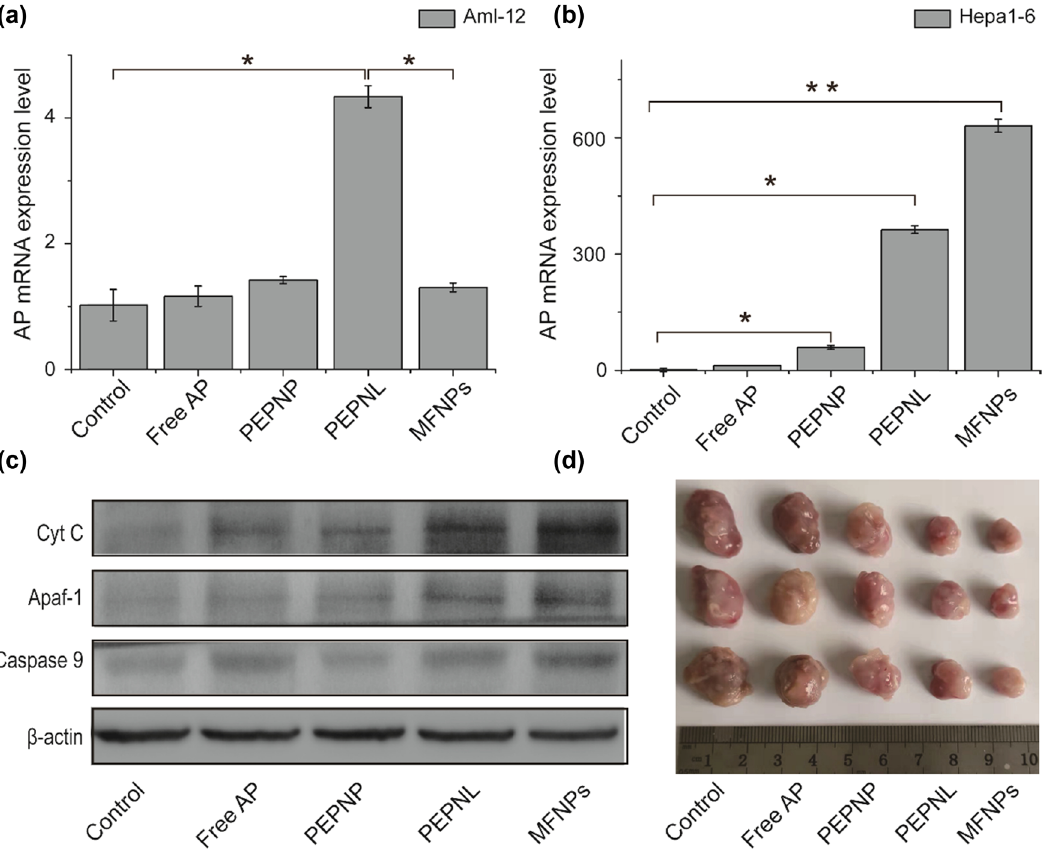
Figure 6: AP mRNA expression level in ( a ) Aml - 12 and ( b ) Hepa1 - 6 cells. ( c ) Apaf - 1, caspase9, and cyt C protein expression due to control, free AP, PEPN - L, and MFNP groups in Hepa1 - 6 cells. ( d ) Solid tumors after 30 days of administration in control, free AP, PEPNL, and MFNP groups. Data presented as mean ± SD ( n = 3 ) , and statistical analyses were performed using a two - sided Student ’ s t - test ( * p < 0.05, ** p < 0.01, *** p < 0.001 )